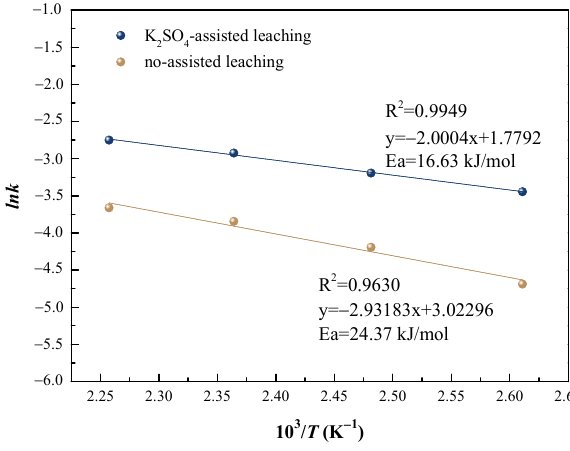
Figure 4. Linear fitting curve of Arrhenius equation under mixed control.